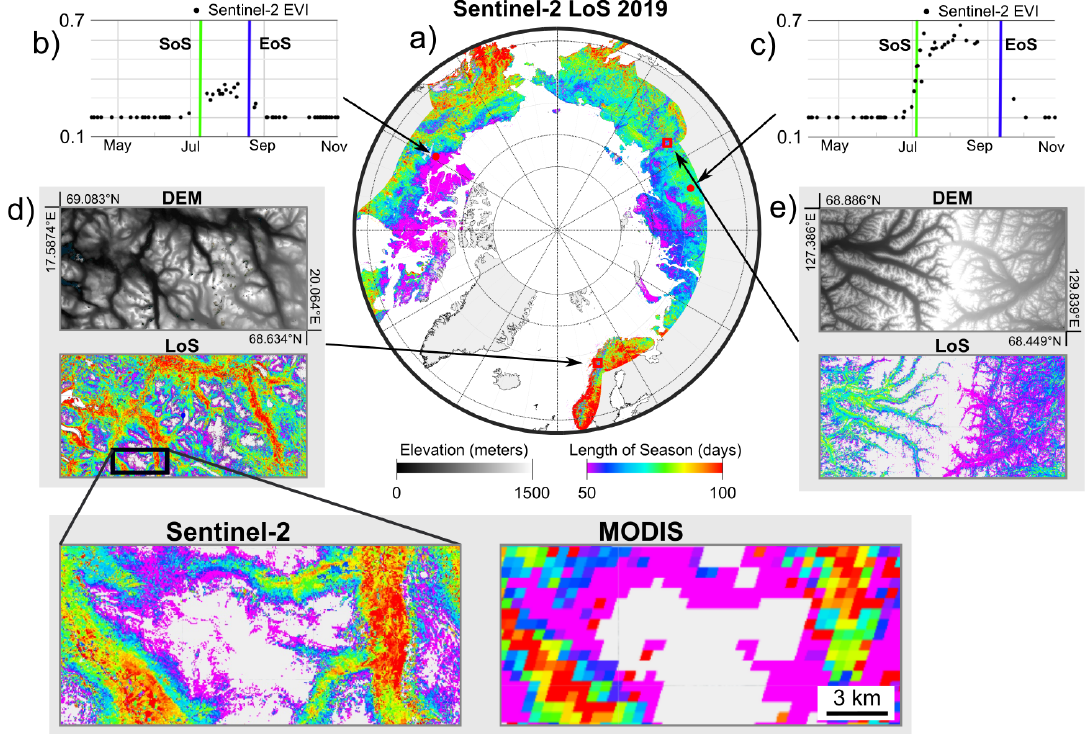
Figure 5. Map of length of season (LoS) in the Arctic estimated using Sentinel-2 enhanced vegetation index (EVI) time series for 2019 ( a ). EVI time series and start of season (SoS) and end of season (EoS) for two randomly selected pixels ( b , c ); note, the time series in ( b ) show a shorter LoS than in ( c ) due to the latitudinal gradient. Arctic digital elevation model map (ArcticDEM) and LoS exemplify the altitudinal gradient of phenology in the Scandinavian mountains and the Ural mountains ( d , e ) and comparison of LoS estimated with Sentinel-2 and Moderate Resolution Imaging Spectroradiometer (MODIS) ( d ). The phenology metrics were extracted with the 50% threshold method applied to the non-smoothed Sentinel-2 EVI time series.